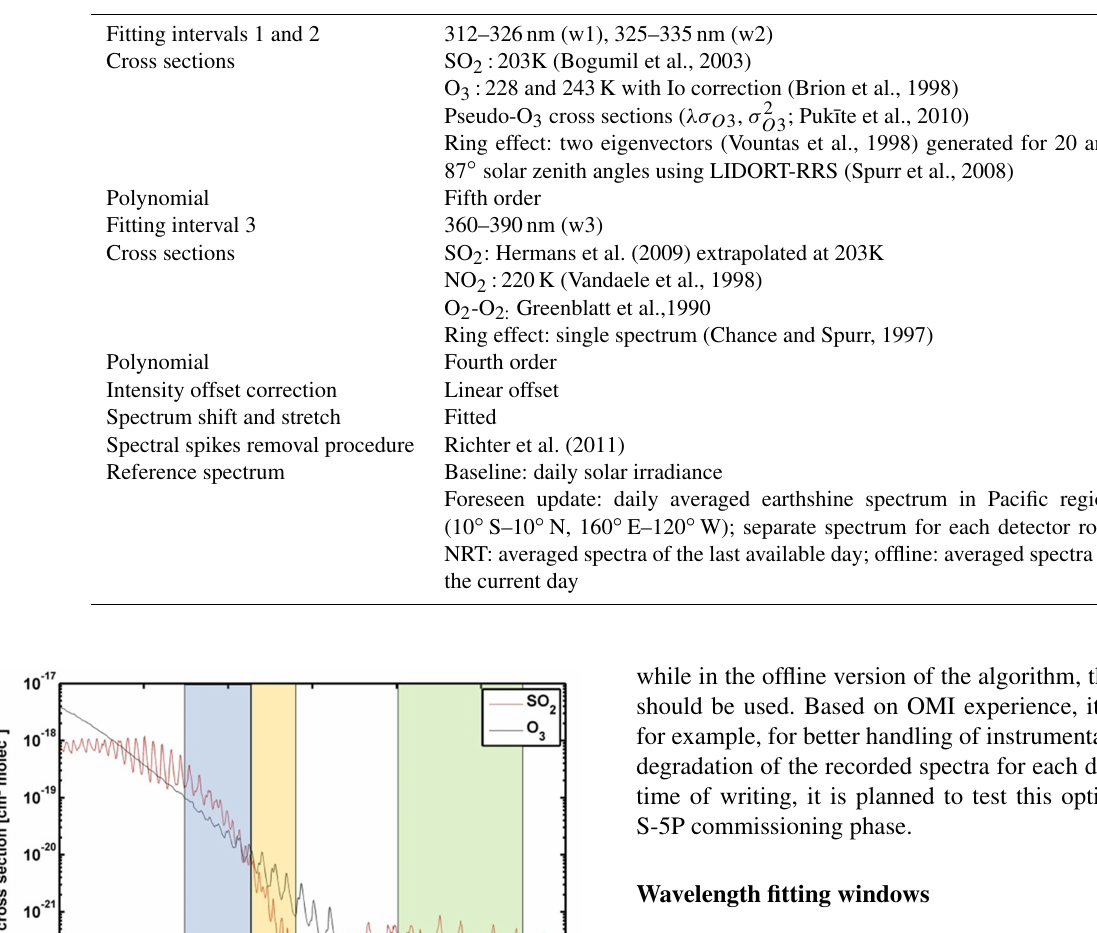
Table 2. DOAS settings used to retrieved SO 2 slant columns.